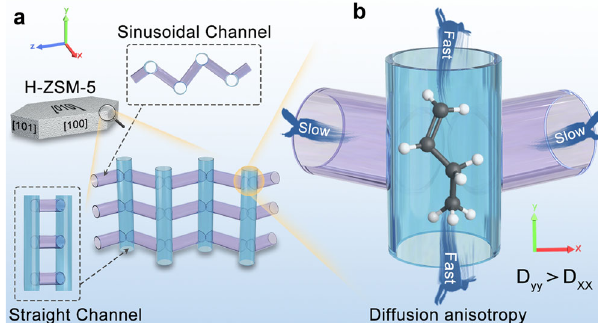
Fig. 1 The framework and diffusion model of H-ZSM-5-type zeolites composed of two-channel directions. a The straight and sinusoidal channels running along b - and a-axis with similar opening sizes but different geometry shapes. b Schematic view of diffusion anisotropy in two-channel network of H-ZSM-5